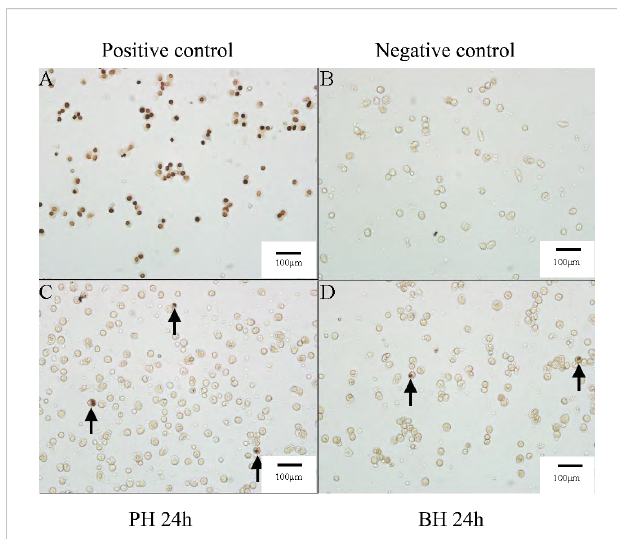
FIGURE 5 Apoptosis results after butyrate stimulation of transplantation at 24 (h) (A) Apoptosis results in positive control group. (B) Apoptosis results in negative control group. (C) Apoptosis results in PH group after transplantation 24 (h) (D) Apoptosis results in BH group after transplantation 24